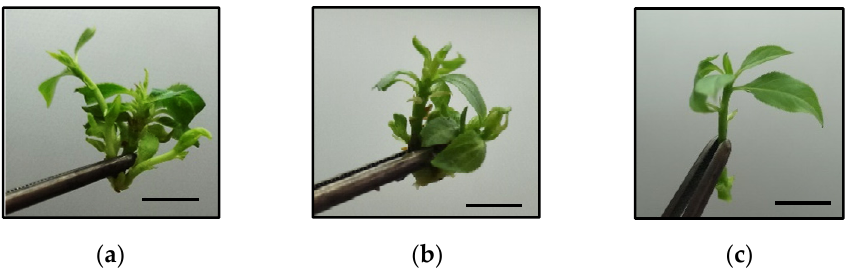
Figure 2. ( a ) Cluster of CFN shoots used as initial explant for experiments regarding the culture system and the hormonal concentration of culture media, ( b ) cluster of CBP shoots used as initial explant for experiments regarding the culture system and the immersion frequency and ( c ) apical section of CBP used as initial experiment regarding growth conditions and sucrose supplementation. Bar: 10 mm.